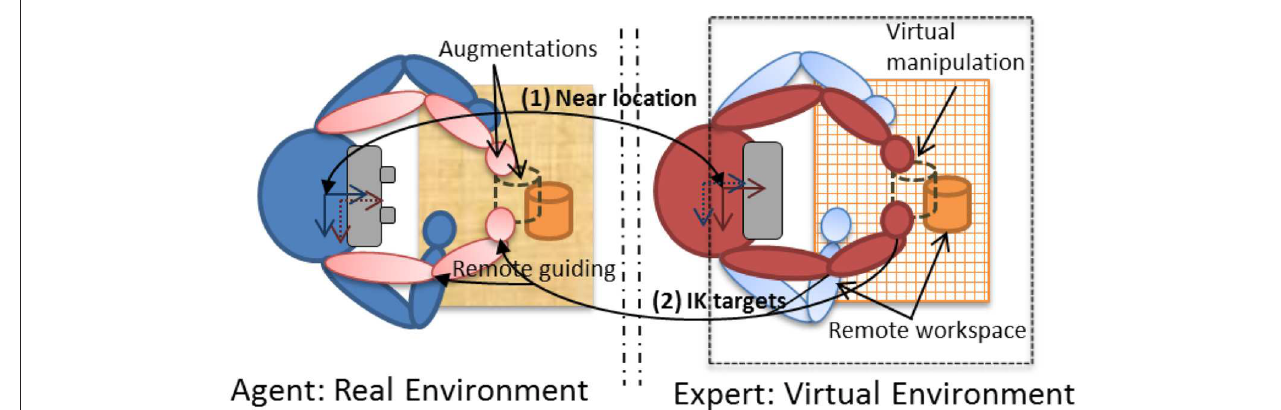
FIGURE 2 | A conceptual top view of the Vishnu paradigm.